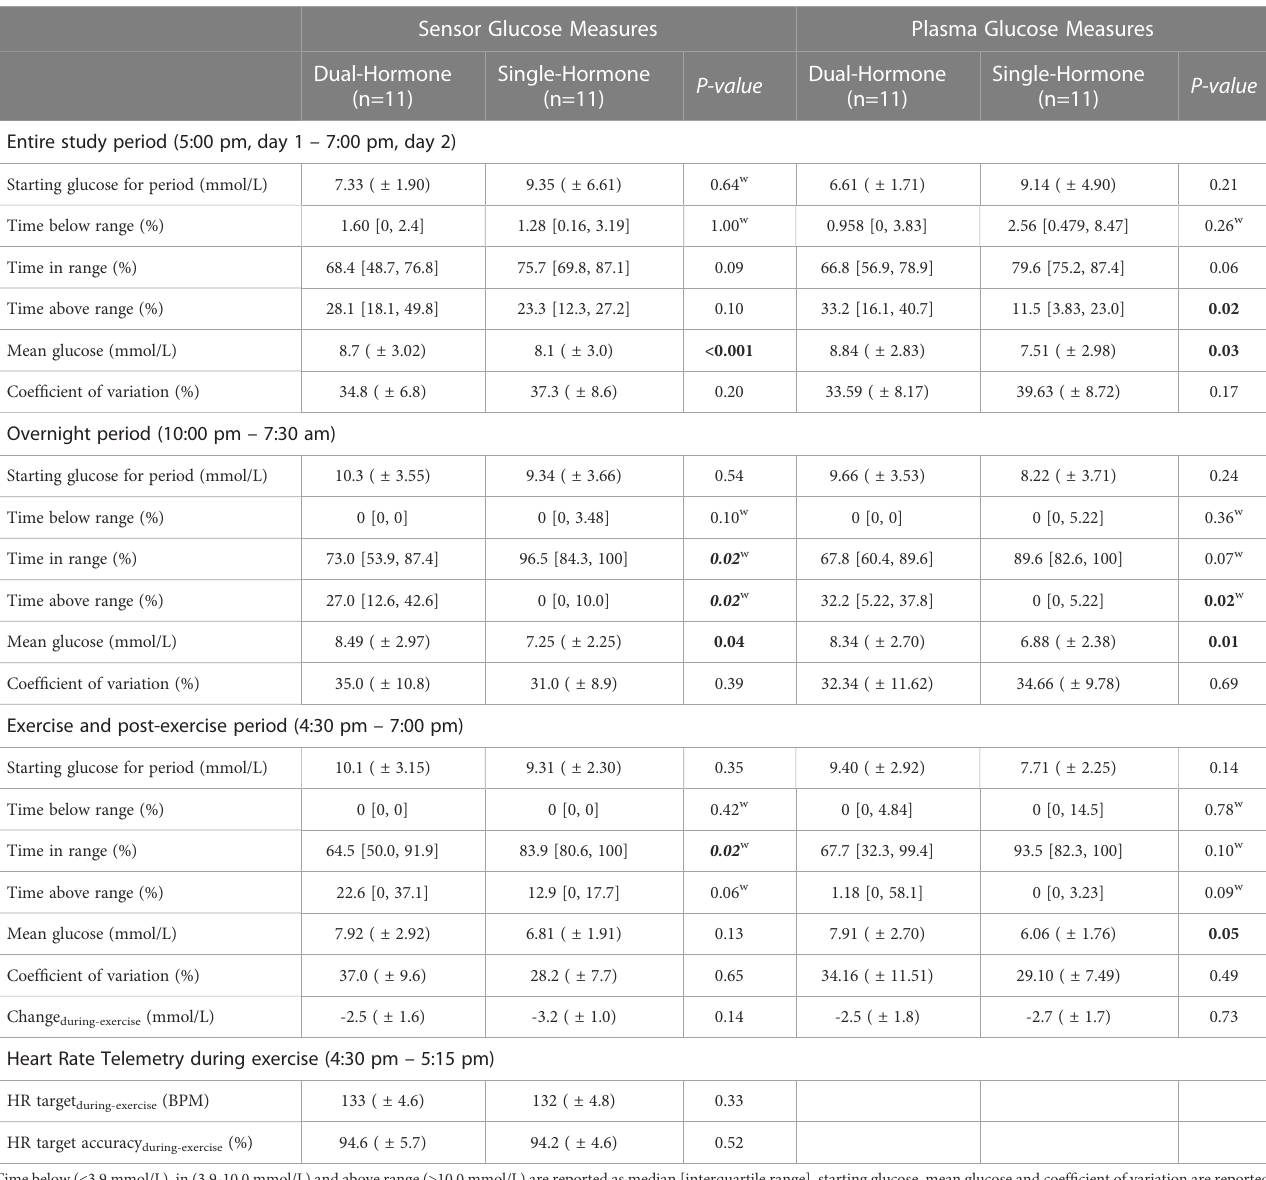
TABLE 2 Sensor and plasma glucose values during entire study, overnight and exercise and post-exercise period. Sensor Glucose